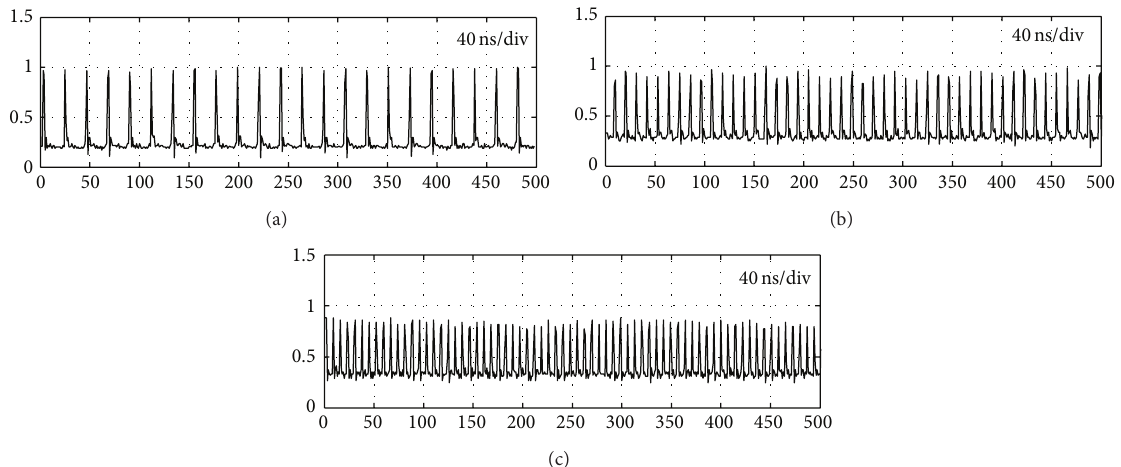
Figure 2: Measured mode-locked pulse trains at different repetition rates. (a) Fundamental mode-locking at 57.5 MHz. (b) Second-harmonic mode-locking at 115MHz. (c) Third-harmonic mode-locking at 172.5